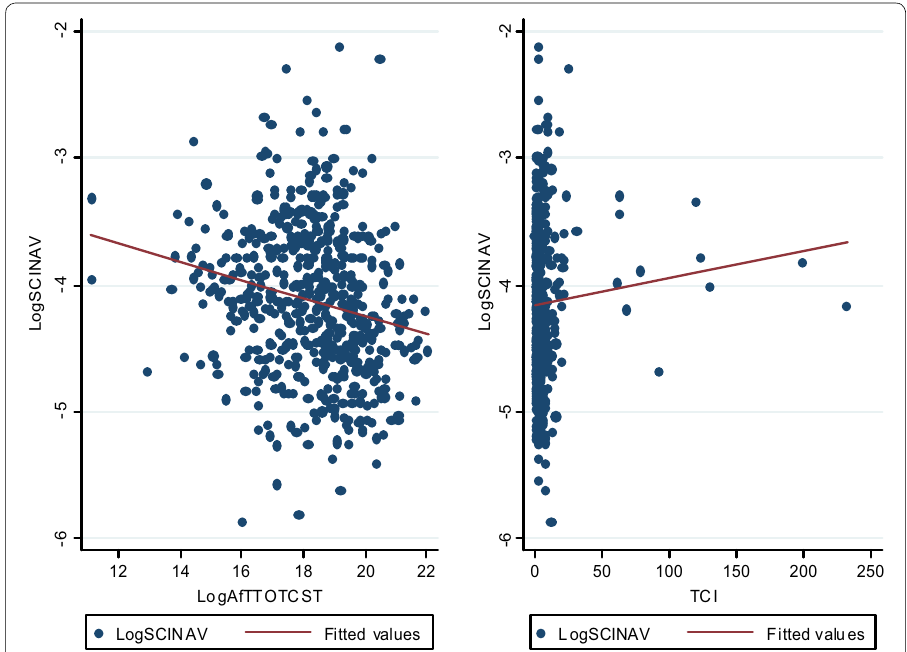
Fig. 3 Correlation pattern between SCNAV (in Logs), TCI, and AfTTOTCST (in Logs) Source: Author